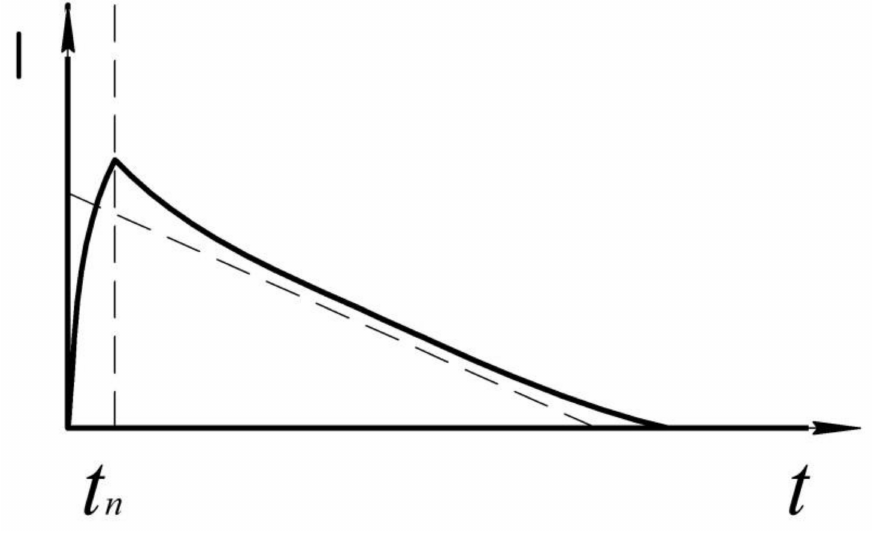
Figure 12. Current